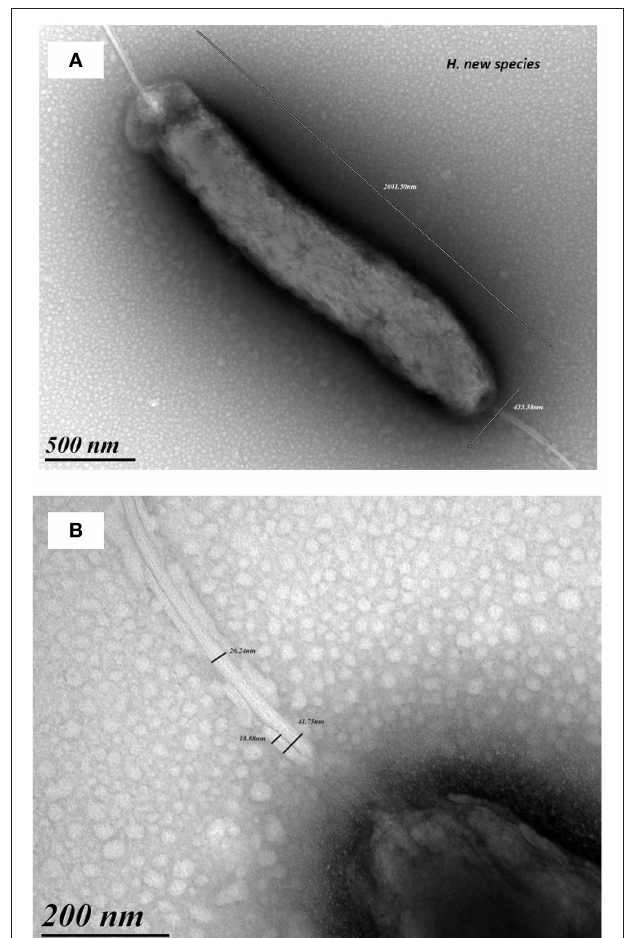
FIGURE 2 | Electron microscopy pictures of strain S15. Microscopic examinations revealed a rod-shaped bacterium 3 µ m in length and 0.5 µ m width (A) . Pictures show amphitrichous sheathed flagella with a diameter around 60nm (B) .